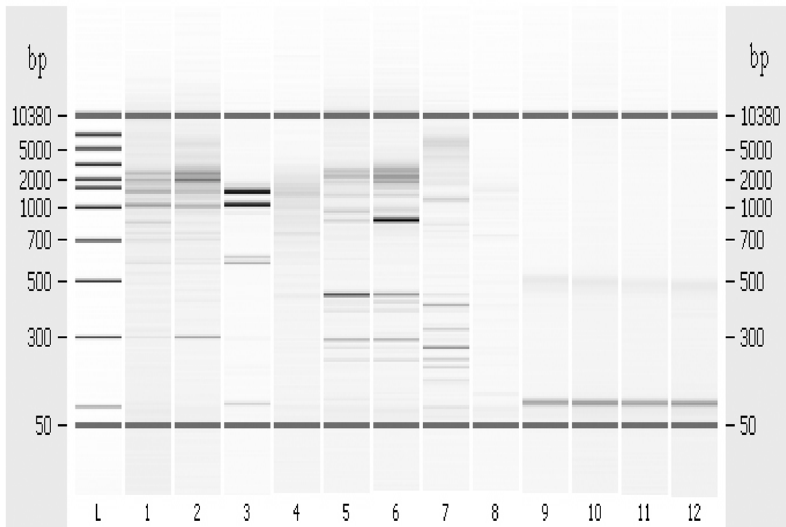
Figure 7. RAPD-PCR-fingerprint. L = Ladder standards. Lanes 1–4, Amplification with OPR2 primer